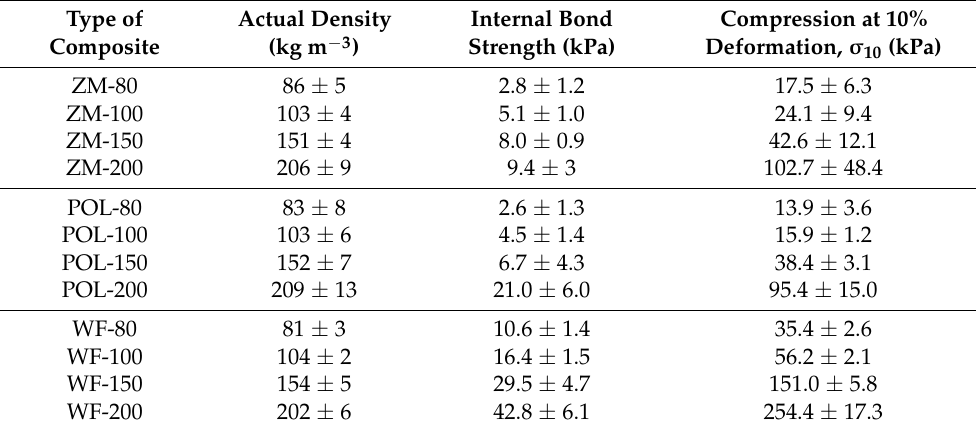
Table 4. Internal bond strength and compression strength of produced composite